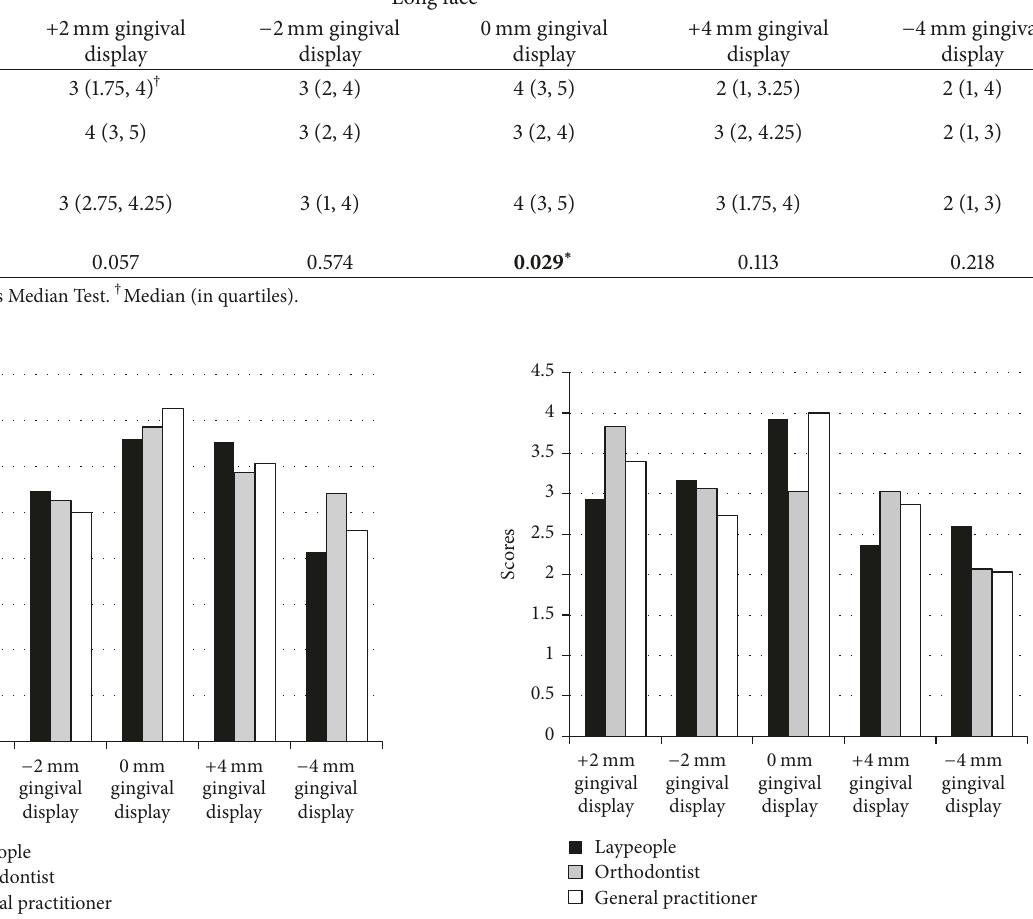
Figure 3: Graphic illustration of numerical rating scale means among groups for short faces.